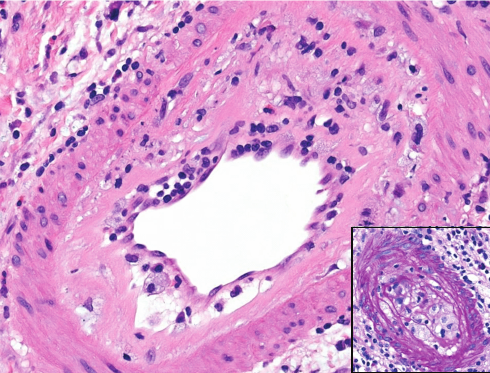
Figure 6: The morphological features of the acute rejection were found in a background of severe chronic allograft arteriopathy (H&E × 40, inset PAS × 200).